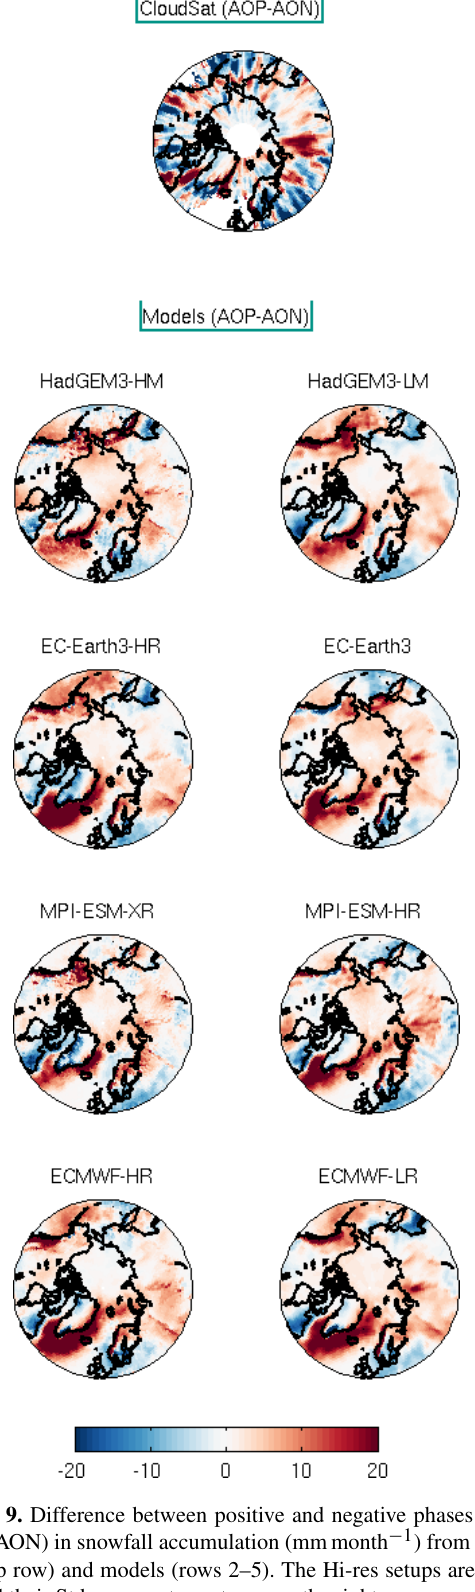
Figure 9. Difference between positive and negative phases of AO (AOP-AON) in snowfall accumulation (mmmonth − 1 ) from Cloud- Sat (top row) and models (rows 2–5). The Hi-res setups are on the left and their Std-res counterparts are on the